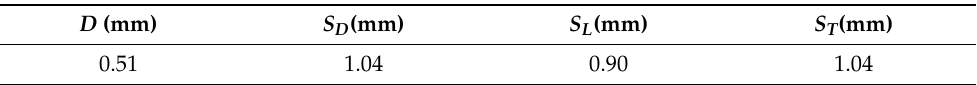
Table 2. Equilateral-triangle equivalent parallel strands. Parameters for the foam sample of Table 1.